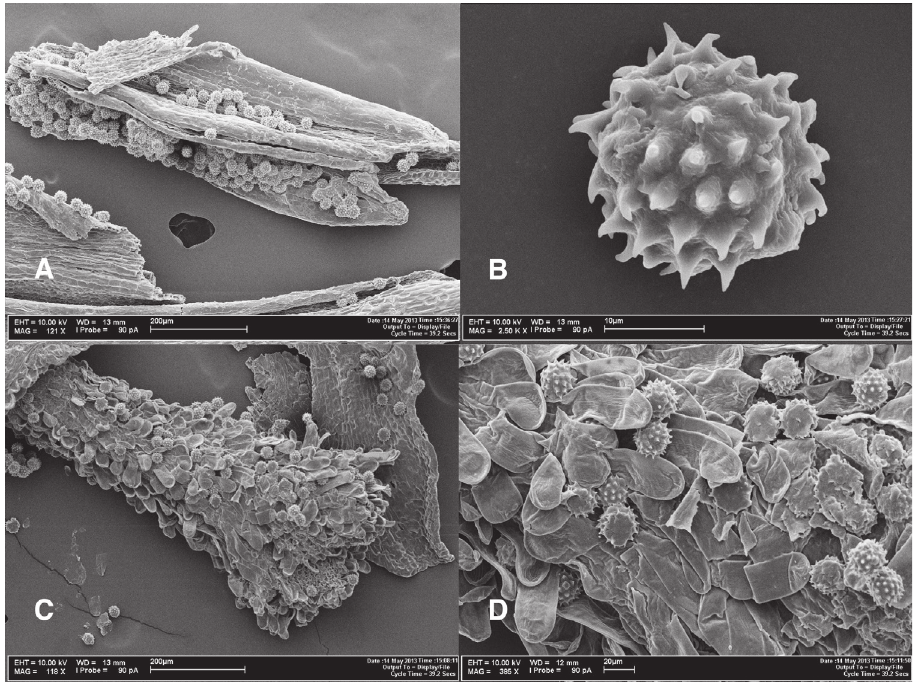
Figure 3. Photomicrographs of Espeletiopsis diazii . A Fragment of anther with pollen grains B pollen grain C disc flower style with pollen grains D papillae of outer side of stigmatic branches, showing pollen